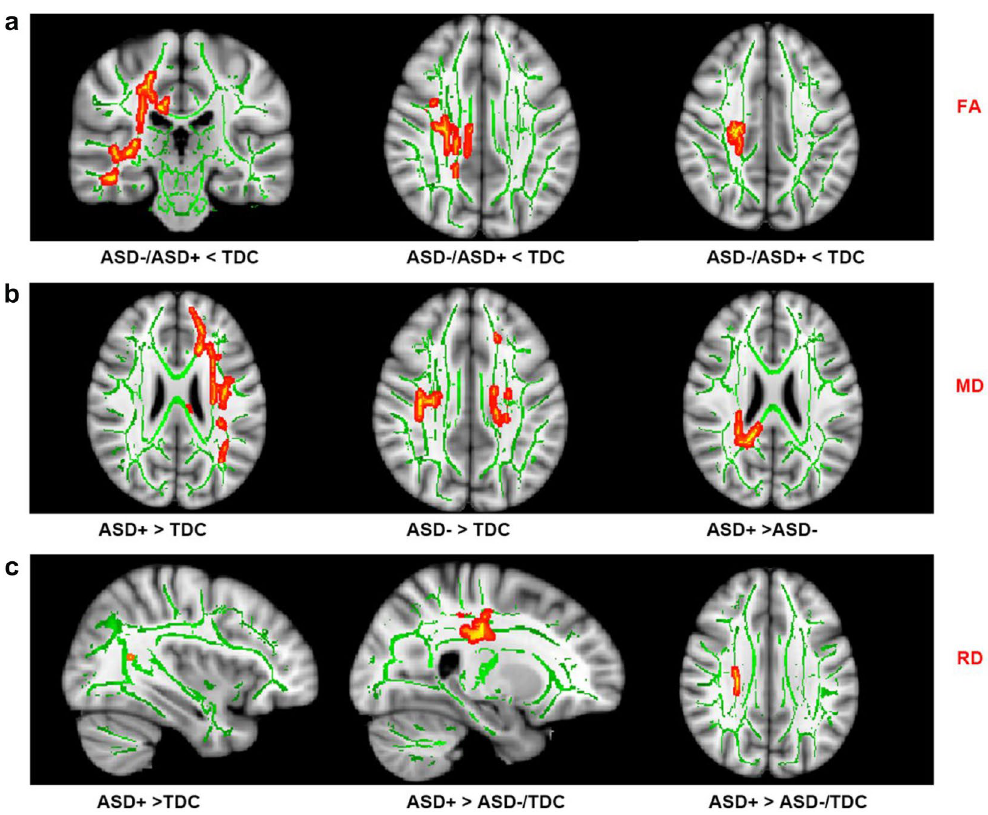
Figure 2. TBSS results among ASD children with optimal outcomes, ASD with persistent symptoms, and controls. TBSS results within the JHU White-Matter Tractography Atlas are reported and labeled accordingly (TFCE FWE corrected, p < 0.05). ANOVA results were symbolled in red. ( a ) FA metrics: ASD−/ASD+ < TDC: Superior longitudinal fasciculus, Inferior longitudinal fasciculus, Forceps major; Cingulum; Corticospinal tract; Inferior fronto-occipital fasciculus; Anterior thalamic radiation; ( b ) MD metrics: ASD+ > TDC: Anterior thalamic radiation; Corticospinal tract L; Cingulum; Inferior fronto-occipital fasciculus L; Superior longitudinal fasciculus; ASD− > TDC: Anterior thalamic radiation R; Corticospinal tract R; Cingulum; Forceps major; Inferior fronto-occipital fasciculus R; Inferior longitudinal fasciculus R; Superior longitudinal fasciculus R; ASD+ > ASD−: Anterior thalamic radiation; Corticospinal tract L; Cingulum L; Forceps major; Inferior fronto-occipital fasciculus L; Inferior longitudinal fasciculus L; Superior longitudinal fasciculus; Uncinate fasciculus L; ( c ) ASD+ > TDC: RD metrics: Inferior longitudinal fasciculus R; Superior longitudinal fasciculus R; ASD+ > ASD−/TDC: Anterior thalamic radiation; Corticospinal tract L; Cingulum L; Inferior fronto-occipital fasciculus L; Inferior longitudinal fasciculus L; Superior longitudinal fasciculus; Uncinate fasciculus